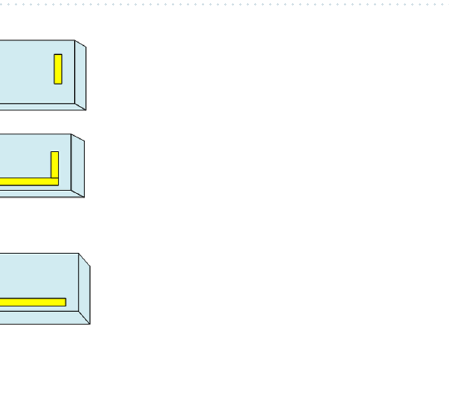
Figure 1. Schematic diagram and geometric parameters of the structure unit cell.